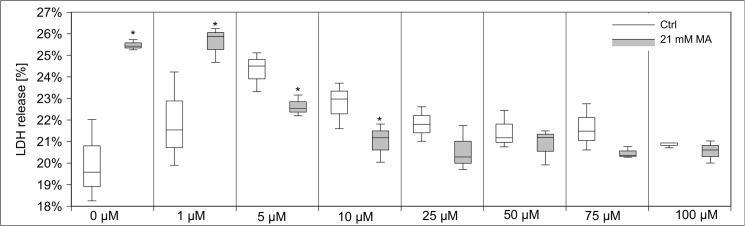
BAPTA-AM reduces MA-induced LDH release.The selective chelator of intracellular Ca2+ stores BAPTA-AM mimicked the previous approach (Fig 13). Data are presented as percent of untreated control of n = 5 independent experiments.